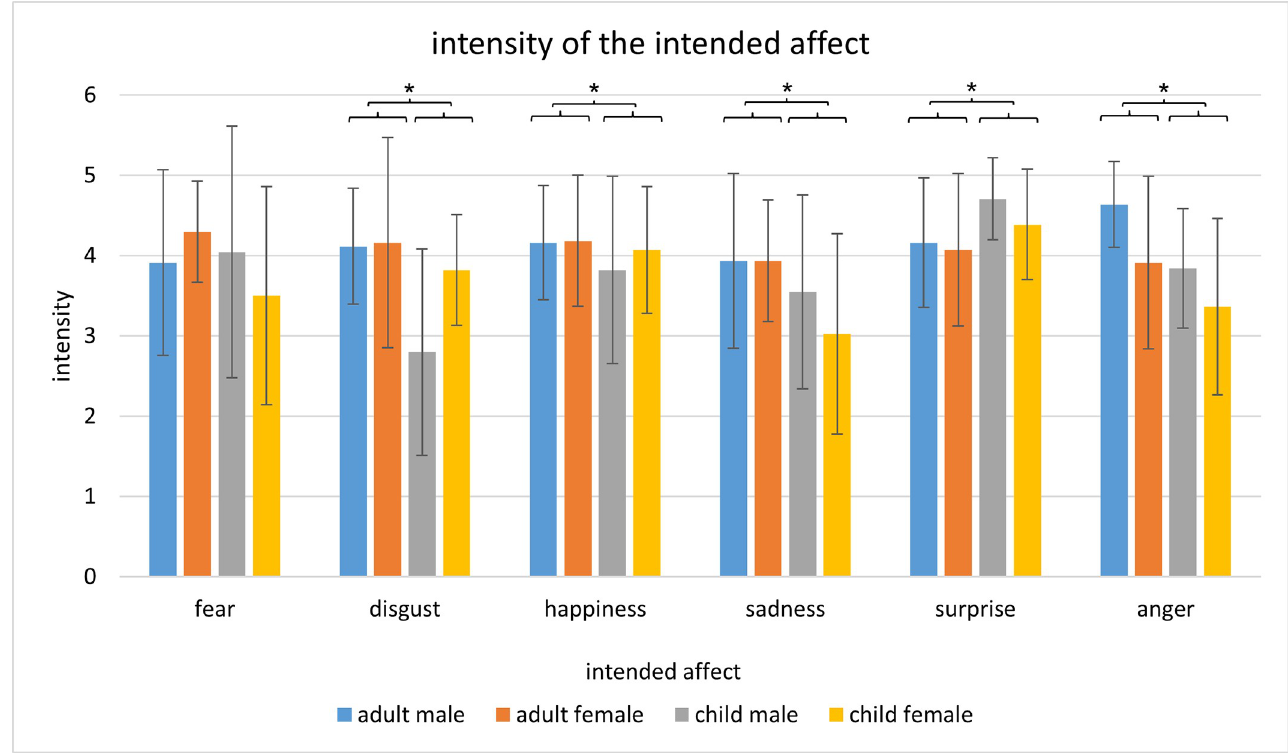
Fig 4. Mean intensity of the intended affect for adults’ and children’s affect expressive faces. The error bars represent the standard deviation. Significant post hoc tests of adults’ and children’s faces (not seperated per sex) are presented as following � < .05.